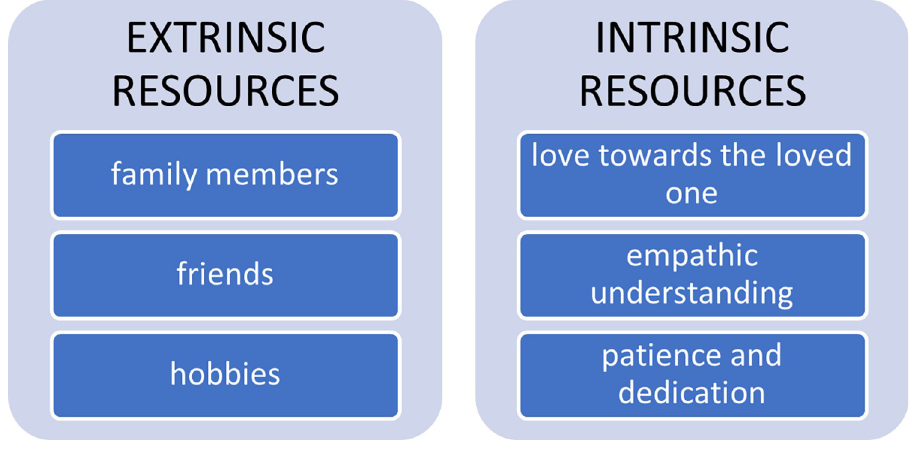
Fig 3. The resources of